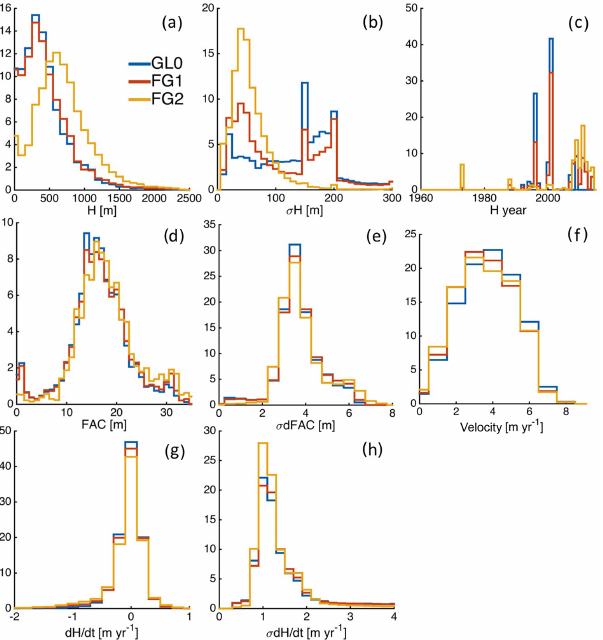
Figure 4. Histograms of ice-equivalent thickness (a) , uncertainty in ice-equivalent thickness (b) , year of ice thickness measurement (c) , firn air content (d) , uncertainty in firn air content (e) , surface veloc- ity (f) , change rate of ice-equivalent thickness (g) and uncertainty in change rate of ice-equivalent thickness (h) for GL0, FG1 and FG2 flux gates. The y axis is the percentage of flux nodes that fall within each histogram bin.